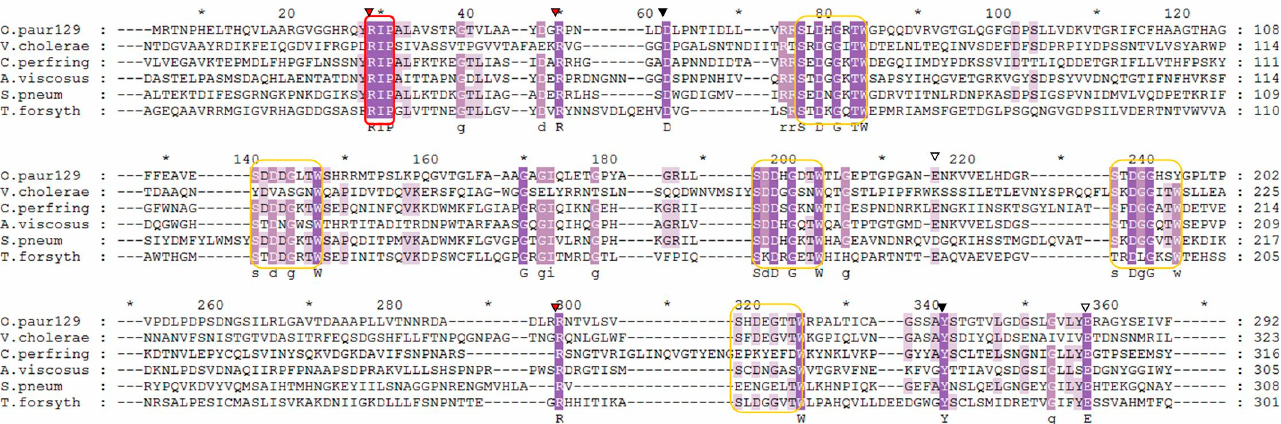
Figure 9. Amino acid sequence alignment of the novel O. paurometabola O129 sialidase (NCBI GenBank accession number OP429228) with the deduced amino acid sequences of the enzymes of V. cholerae (AWB74302.1), C. perfringens (APZ74275.1), A. viscosus (VEI16517.1), Str. pneumoniae (WP_129559156.1), and Tannerella forsythia (CQ24155.1). Full identity is outlined in dark violet, partial identity, in light violet, and lack of identity, in white. The Y/FRIP motif is enclosed in a red rectangle; the Asp-boxes are enclosed in yellow rectangles. The predicted conserved catalytic residues are marked with inverted triangles—red for the arginine triad, white for glutamate, and black for aspartate and tyrosine.